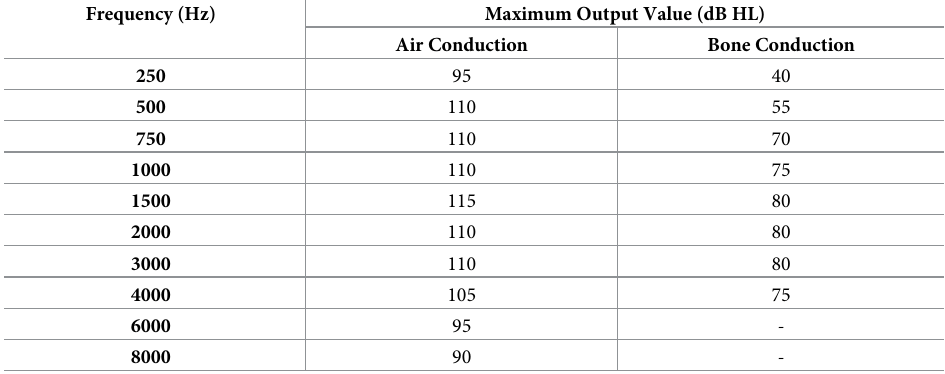
Table 1. Maximum output value (dB HL) for air and bone conduction across frequencies using an external sound card.